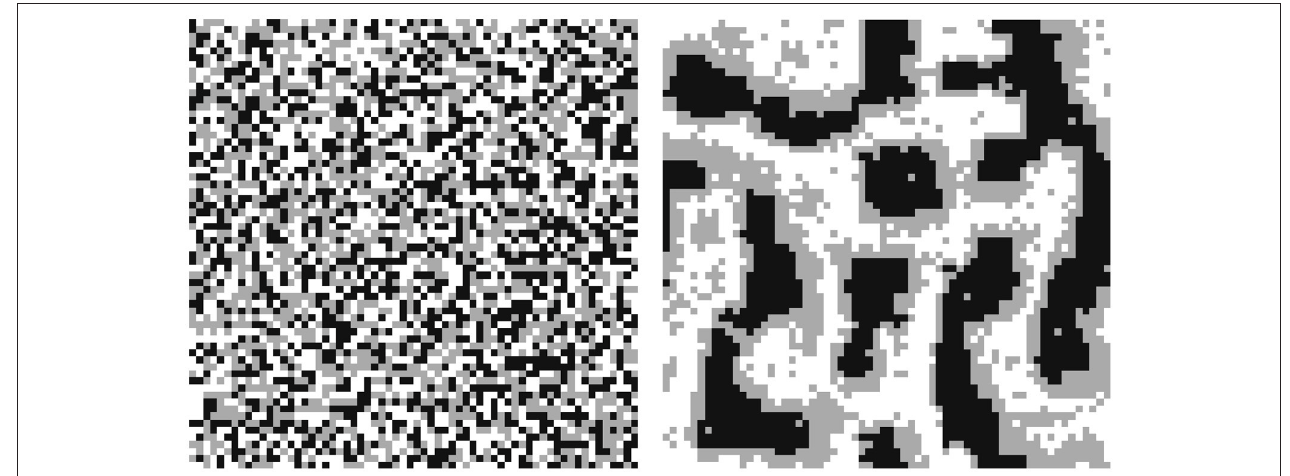
FIGURE 6 | CAM including the reorganization of the gas phase illustrating its non-wetting property. Random initial configuration (left) and quasi stationary consolidated configuration (right) with solid (black), gas (white), and fluid (gray).